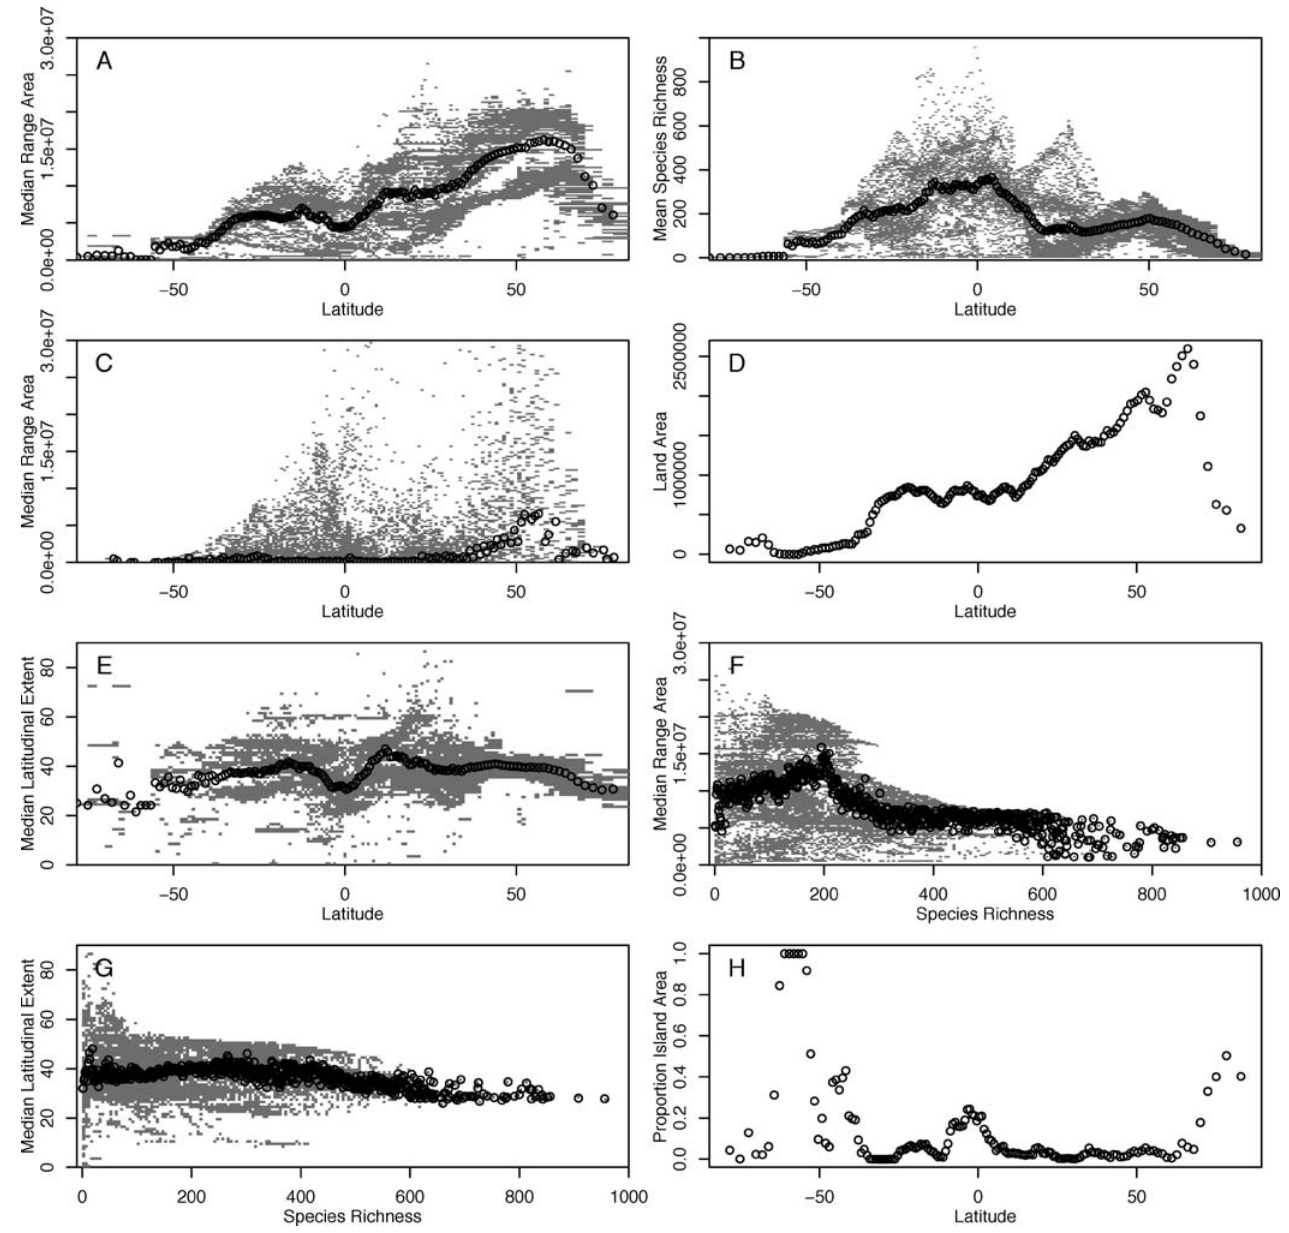
Figure 3. Global Relationships between Geographic Range Area, Latitudinal Range Extent, Species Richness, Land Area, Island Area, and Latitude (A) Median geographic range area and latitude. (B) Species richness and latitude. (C) Median range area and latitude for species with midpoints falling in each respective latitudinal band. (D) Total land area (km 2 ) within latitudinal bands. (E) Median latitudinal range extent and latitude. (F) Median geographic range area and species richness. (G) Median latitudinal range extent and species richness. (H) Proportion island area and latitude. For (A–C) and (E and F), open circles represent latitudinal means, and grey points show the spread of individual grid cell values. Southern latitudes are indicated as negative, northern ones as positive. DOI: 10.1371/journal.pbio.0040208.g003 versus latitude for cell averages per latitudinal band: southern hemisphere r ¼(cid:2) 0.98, n ¼ 75, p (cid:1) 0.001, northern hemisphere r ¼ (cid:2) 0.77, n ¼ 76, p (cid:1) 0.001). In addition, the southern hemisphere shows both higher diversity at mid-low latitudes and a steeper decline with increasing latitude than the northern hemisphere (Figure 3B). These analyses are not sensitive either to the omission of island cells or to more conservative tests using differences in latitudinal values that account for latitudinal autocorrelation (see Protocol S2). PLoS Biology |